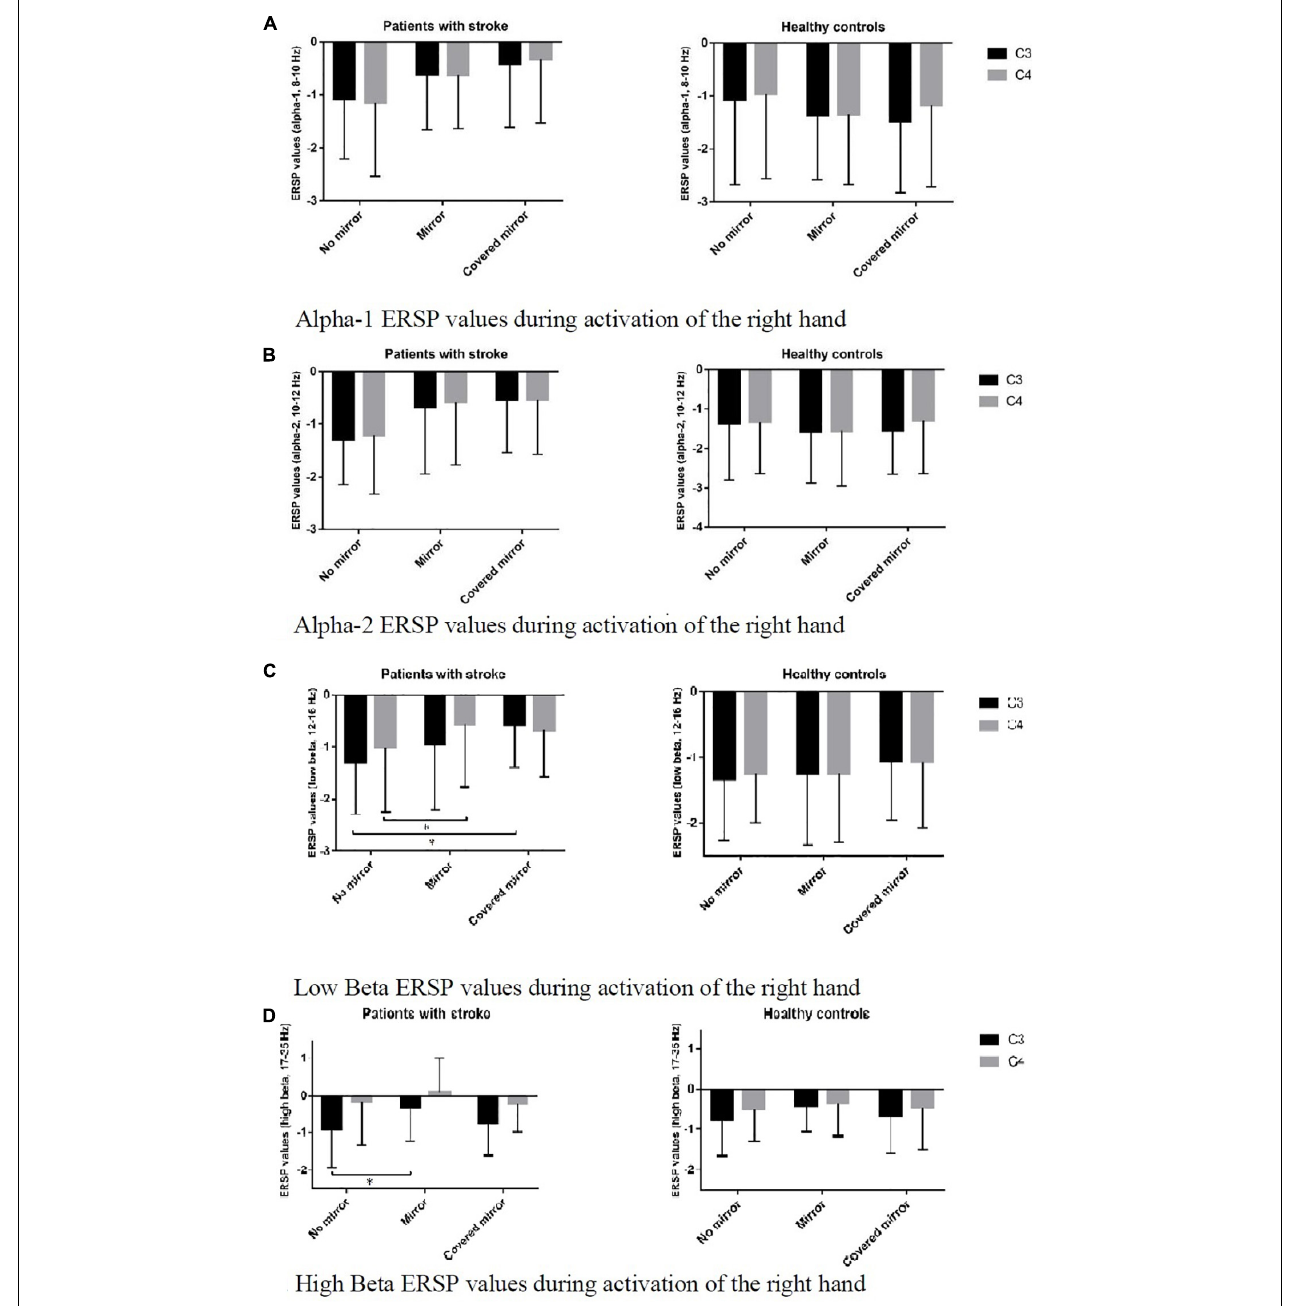
FIGURE 3 | ERSP values of C3 and C4 in three task conditions in each frequency band, in two groups: stroke patients and healthy controls. (A) Alpha-1 ERSP values during activation of the right hand. (B) Alpha-2 ERSP values during activation of the right hand. (C) Low Beta ERSP values during activation of the right hand. * p < 0.05. (D) High Beta ERSP values during activation of the right hand. * p <